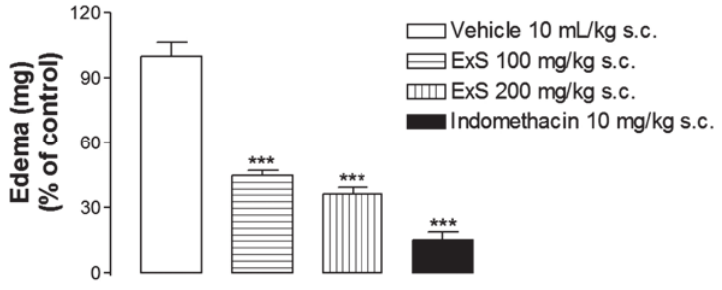
Figure 3 - Effect of Streptoverticillium sp. extracts, ExS 100 and 200 mg/ kg, s.c., on croton oil-induced ear edema in mice. The vertical bars indicate the mean ± SEM of differences in weight between right and left ear plugs. Indomethacin (10 mg/kg, s.c.) was used as a positive control. *** p < 0.001, vs control group